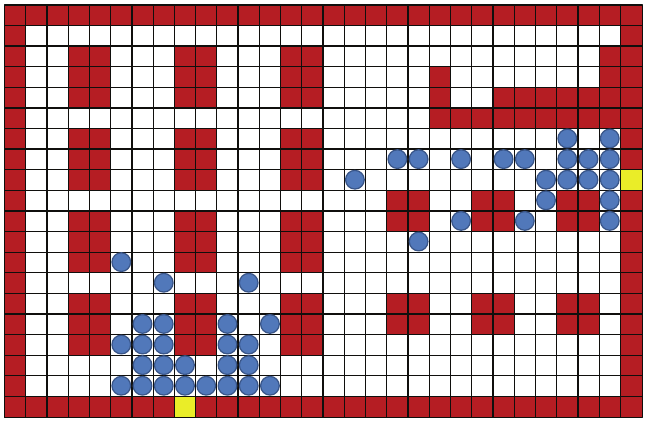
Figure 21: Snapshot of a simulation with 112 persons in the floor field from Figure 12 after 85 time